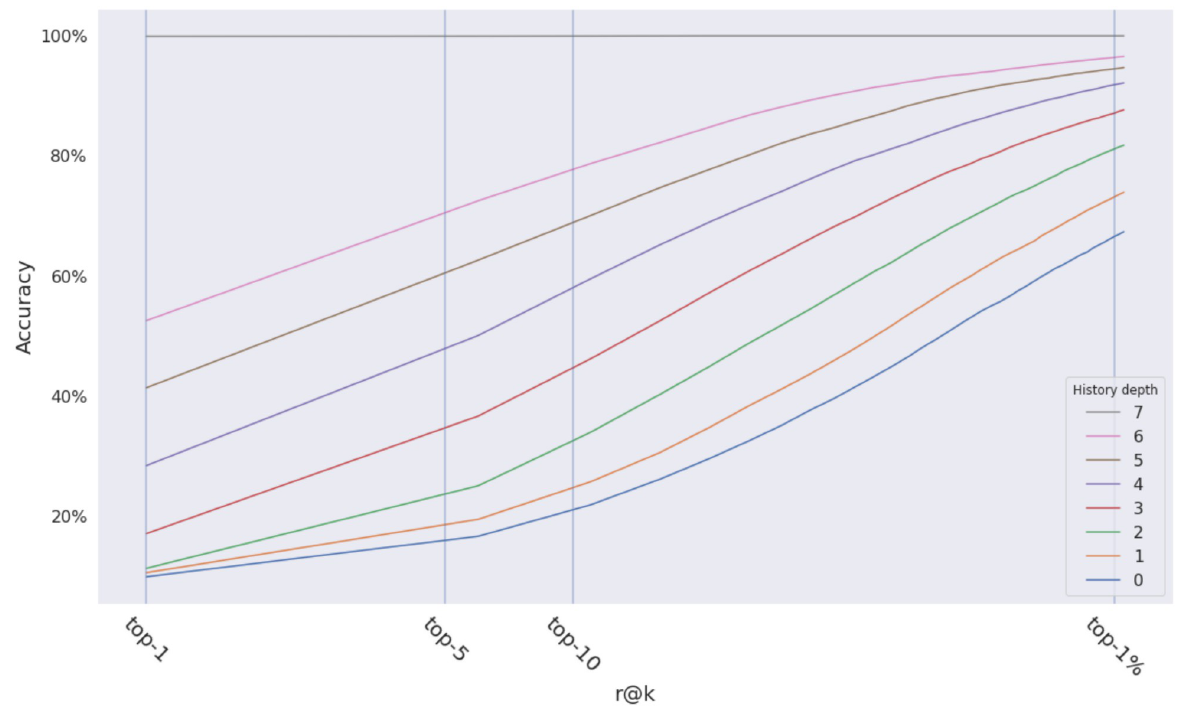
Fig 16. The effect of the number of steps we look back on the accuracy.